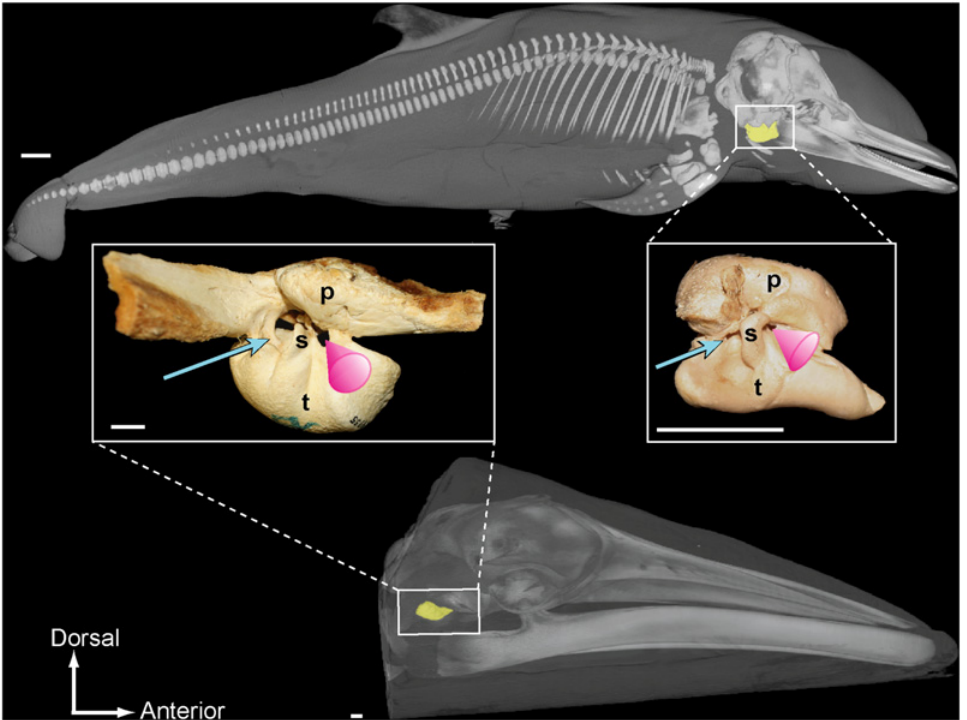
Fig 1. CT-based three-dimensional reconstructions of a toothed whale and baleen whale, right lateral view. Top: Stenella attenuata (USNM 504048). Bottom: Balaenoptera acutorostrata , juvenile specimen not part of this study. The tympanoperiotic complex houses the middle and inner ear structures, and is highlighted in yellow. The insert images are photographs of prepared tympanoperiotic complexes from mature individuals: B . bonarensis (USNM 504955) and S . attenuata (USNM 487880). The tympanic aperture is indicated by the blue arrow and the acoustic funnel is illustrated by the pink cone. Scale bar = 2